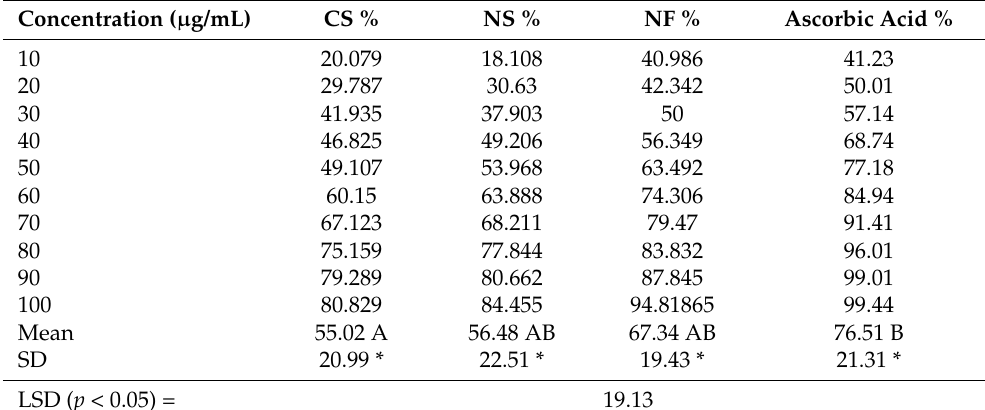
Table 4. DPPH inhibition (%) of different concentrations of PCL/CS/NS nanofiber mats. Concentration ( µ